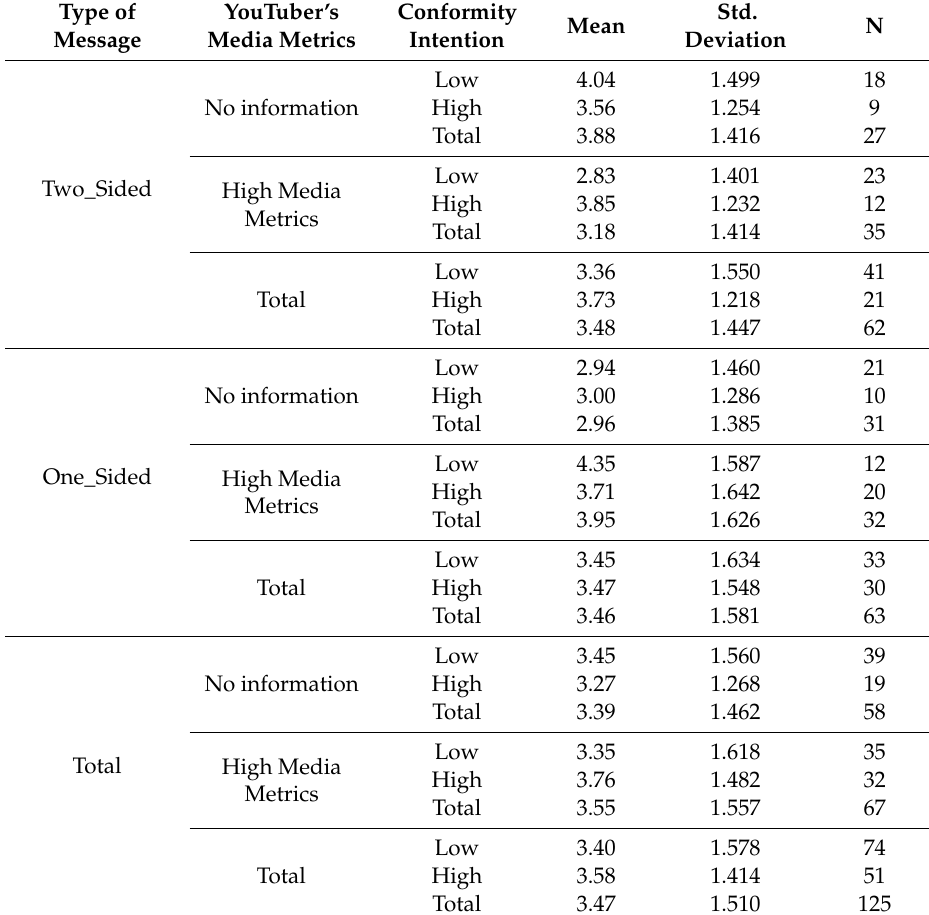
Table 2. Descriptive statistics for attitude towards the vlog by type of message X YouTuber’s media metrics and conformity